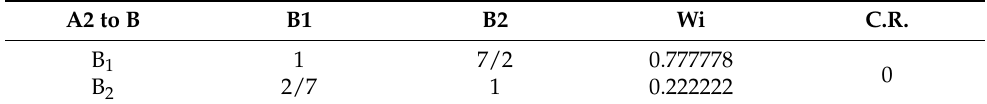
Table 9. Judgment Matrix of A2 to B.